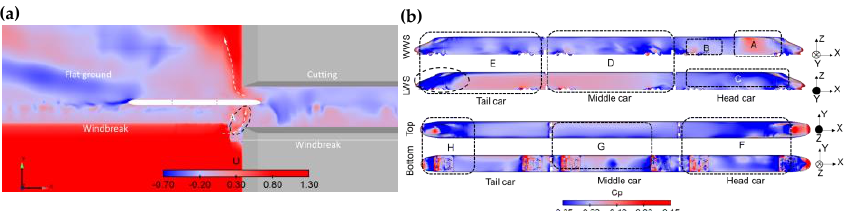
Figure 11. ( a ) The distribution of the wind speed coefficient ( U ) at a height of 0.5 h and ( b ) pressure distribution on the train surface.